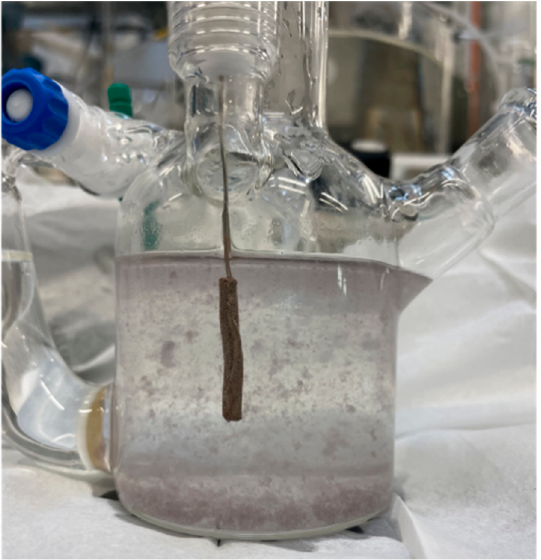
Figure 12. Example of precipitation observed in CaCl 2 after electrochemical corrosion experiments (pictured with CE still immersed in solution; RHE and WE removed).